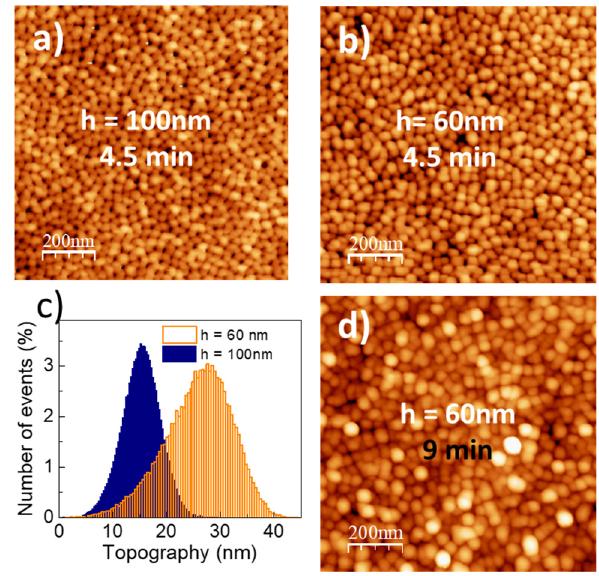
Figure 4. AFM images of ( a ) h = 100 nm ( b ) h = 60 nm t = 4.5 min and ( d ) h = 60 nm t = 9 min membranes. ( c ) Height distributions of the membranes in ( a ) and ( b ).